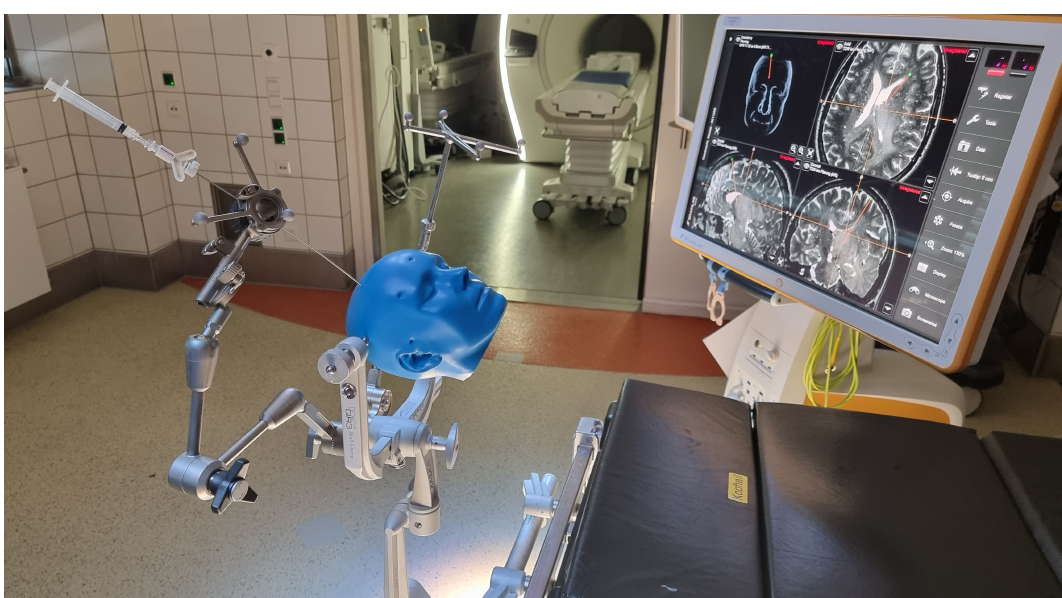
Figure 2. VarioGuide intraoperative setting